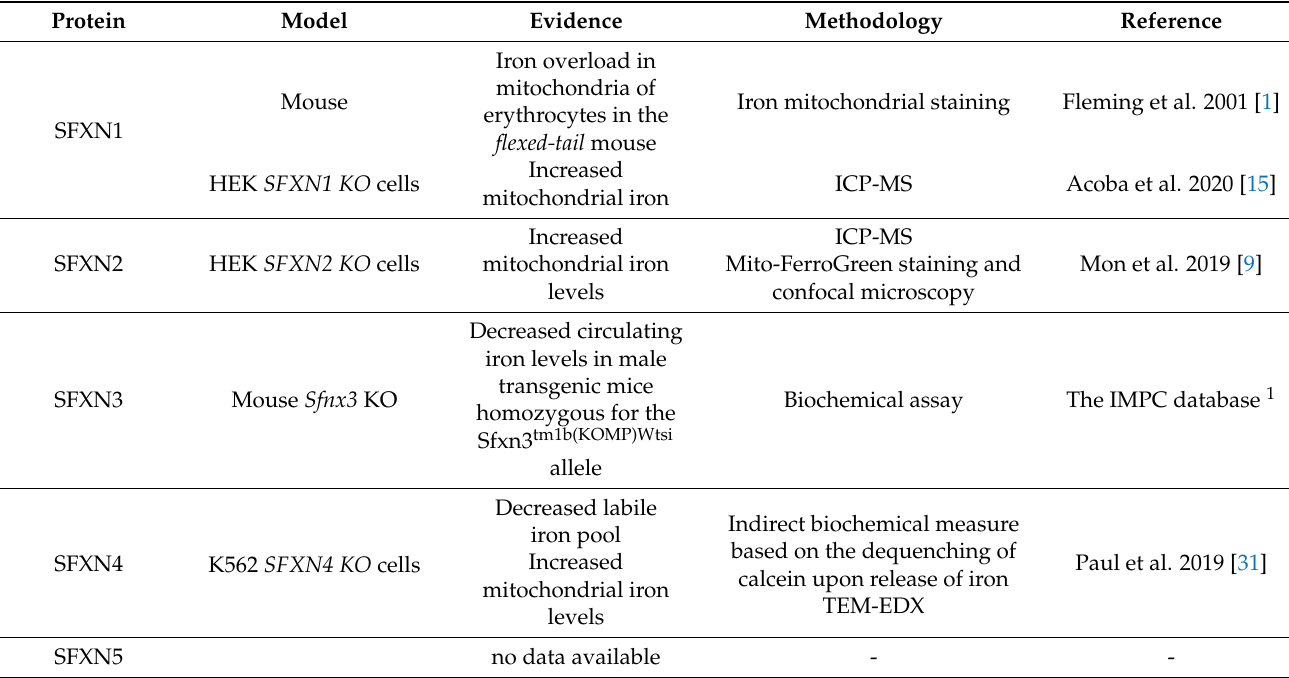
Table 3. Regulation of systemic or cellular iron levels by